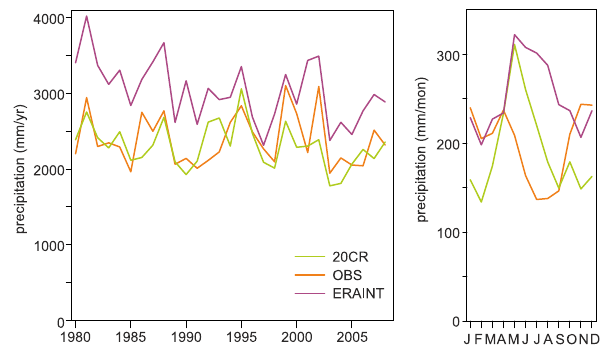
Fig. 3. Annual mean precipitation and mean seasonal cycle of pre- cipitation over the period 1980–2008 from Great St Bernard station data, ERA-Interim, and